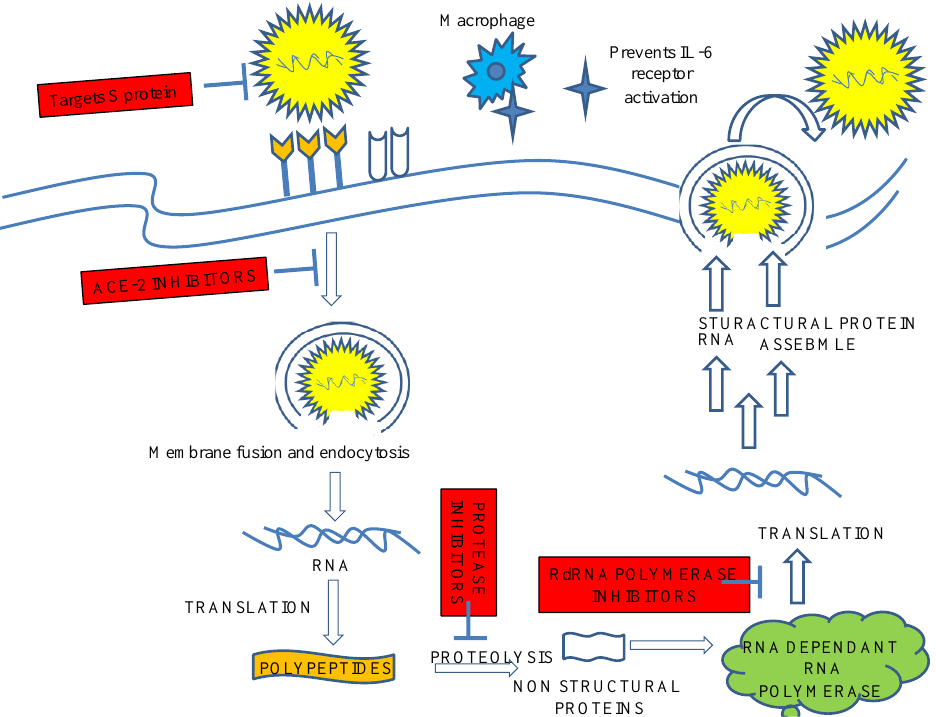
Figure 3. Possible beneficial targets in ACE2-mediated SARS-CoV-2 infection. SARS-CoV-2 binds the cell receptor ACE-2 to facilitate entry after the spike protein is primed by membrane protease. The virus then replicates abundantly, producing replicates that efflux from host cells, resulting in damage and spreading. Potential therapeutic approaches include the use of a soluble form of ACE2 that competitively binds viruses.